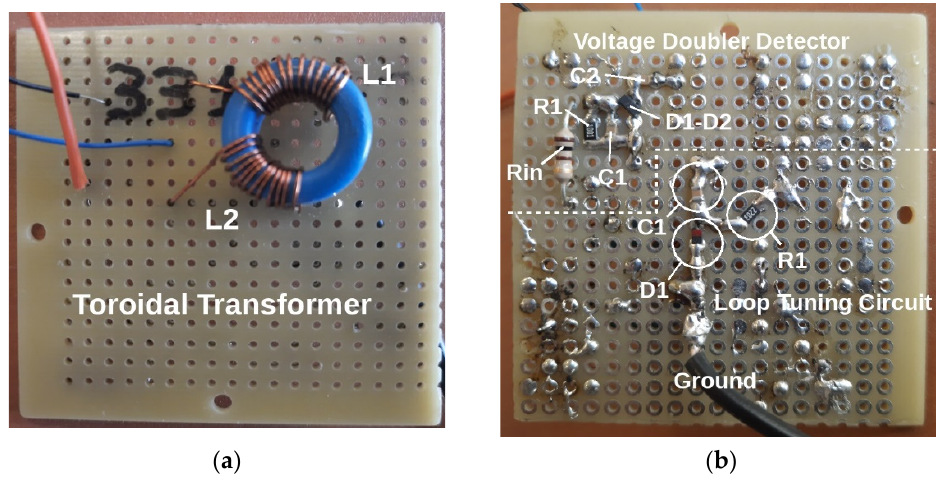
Figure 5. Picture of the electronics developed for loop automatic tuning: ( a ) front side; ( b ) back side.